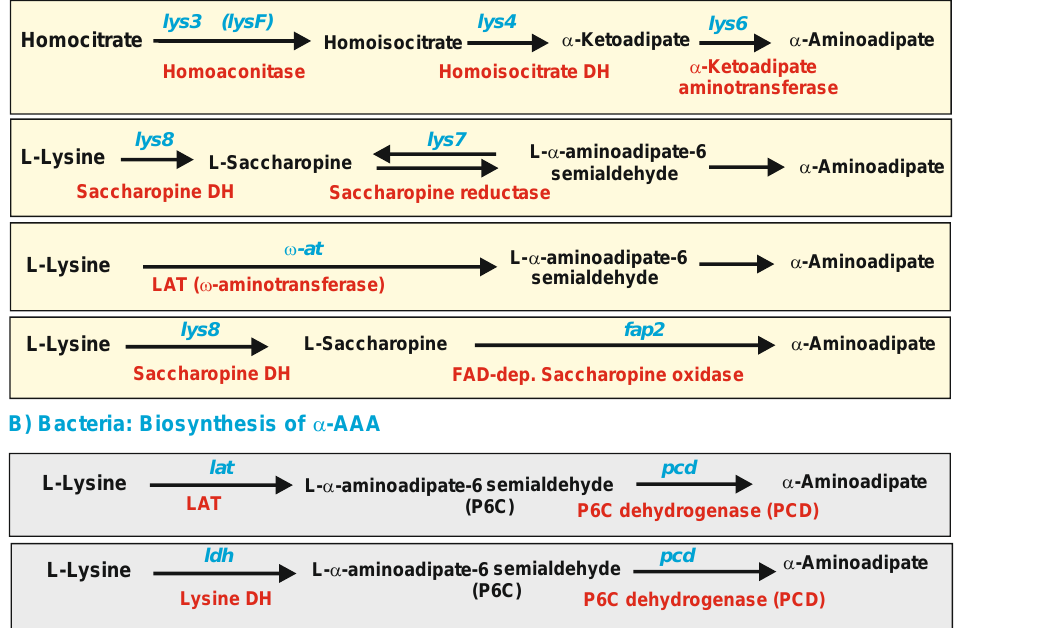
Figure 3. Biosynthetic pathways of α -Aminoadipic acid. ( A ) Biosynthesis of α -Aminoadipic acid in filamentous fungi. All the pathways have a yellow background. ( B ) Biosynthesis of α -Aminoadipic acid in bacteria. All the pathways have a gray background. The enzymes involved in every step are shown in red letters; the genes are shown in blue letters. Note that the enzyme forming α -AAA from aminoadipate-6 semialdehyde in fungi is unclear (see text); the name of the gene encoding the lysine dehydrogenase of A. tumefaciens has been designated ldh .